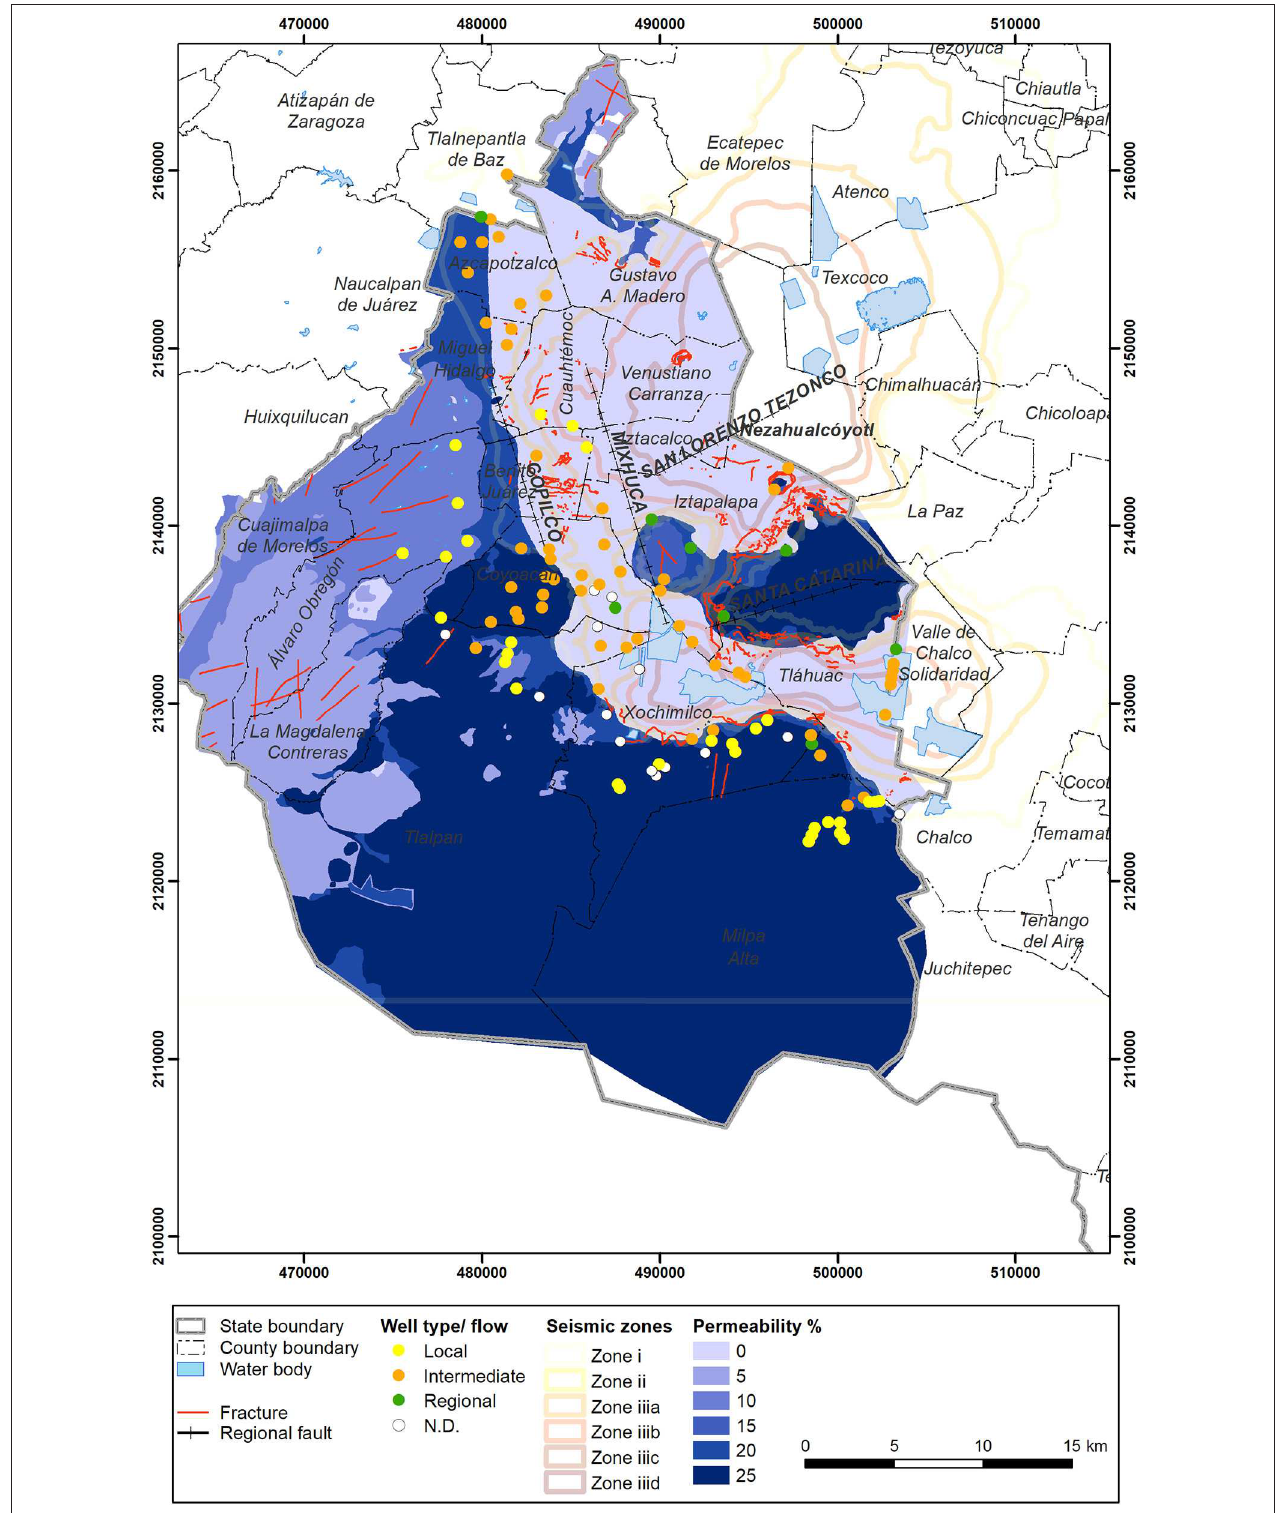
FIGURE 5 | Spatial representation of permeabilities and wells with different flows local (yellow), intermediate (orange), and regional (green).